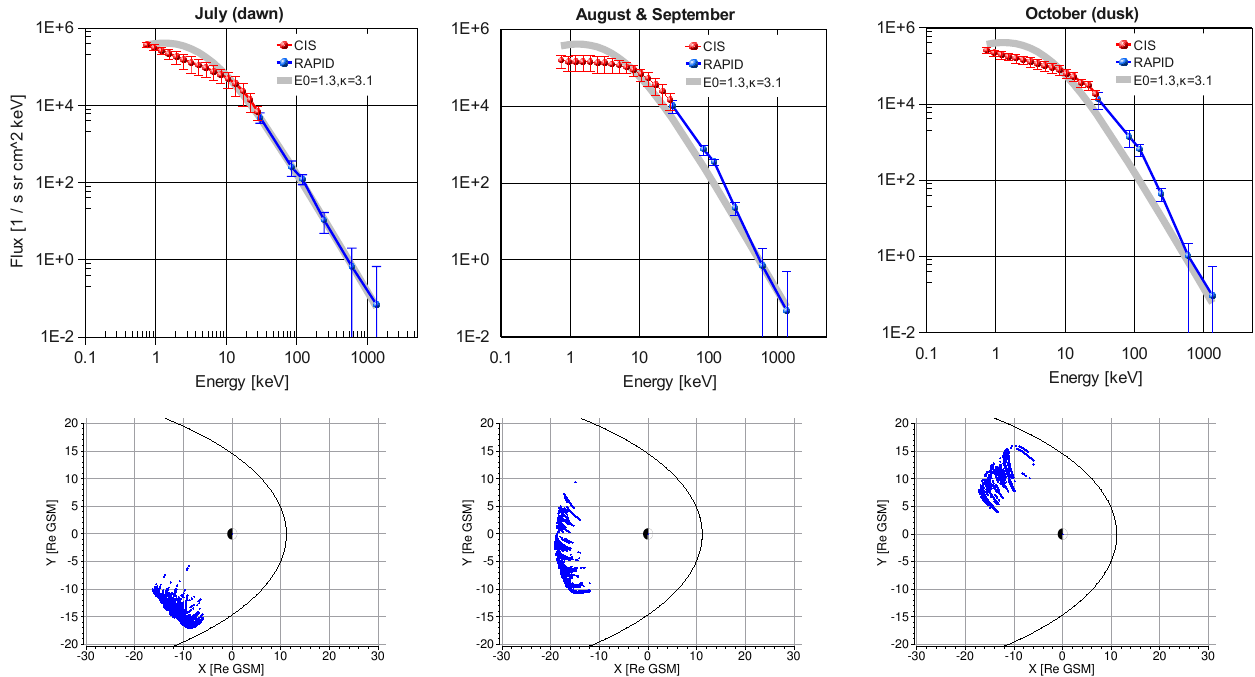
Fig. 7. Seasonal dependence of average energy spectra. Top left panel: Average spectrum for the dawn side (measurements from July only). Top center panel: Average spectrum for the 22:00–02:00 local time sector (measurements from August and September crossings only) Top right panel: corresponding spectrum for the dusk side (measurements from October only). The gray curve in the top panels represents a visual fit to the high energy part of the July spectrum. The lower panels show XY GSM projections of the orbit segments where the respective average spectra were